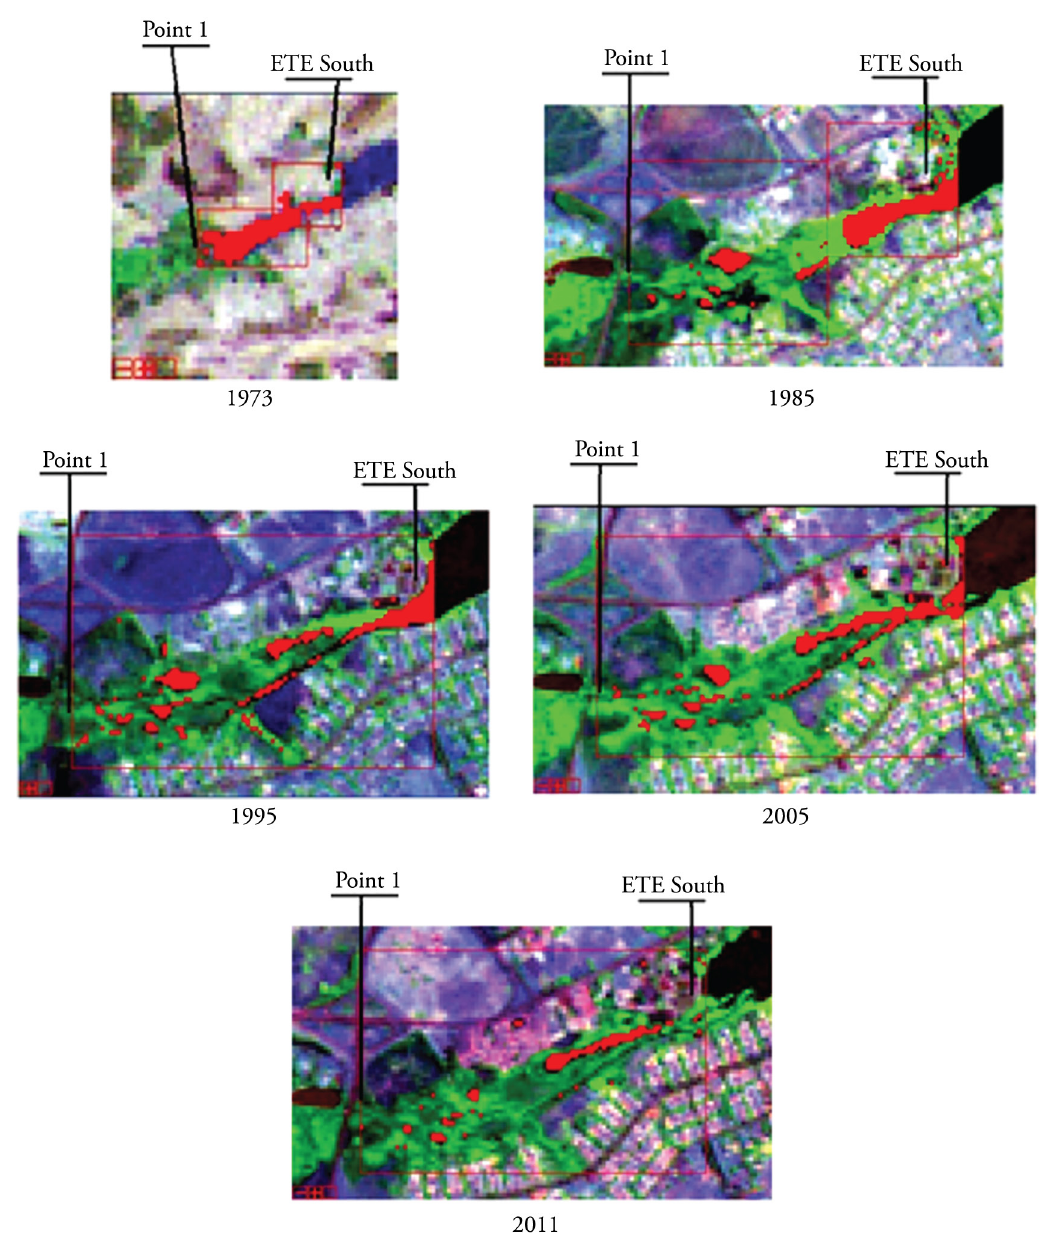
Figure 5. Comparison between the years 1973, 1985, 1995, 2005 and 2011 of wetland growth. The red spots are water area and the green spot